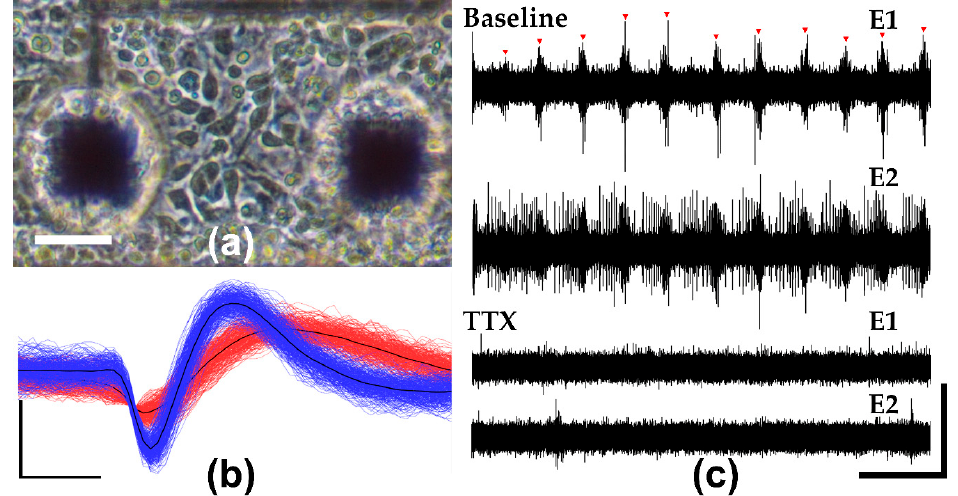
Figure 5. Neuronal Recordings and pharmacology on LCE MEAs: ( a ) Phase contrast image of cultured cortical neurons on LCE MEA DIV2. Scale bar represents 30 μ m. ( b ) Representative extracellular waveforms recorded from LCE MEAs on DIV 21. Vertical and horizontal scale bars represent 40 μ V and 280 μ s. ( c ) Representative bandpass-filtered extracellular recordings from 2 representative electrodes on a single MEA (DIV 27) before and after application of TTX. Red arrowheads indicate network bursts. Vertical and horizontal scale bars represent 55 μ V and 2 s.